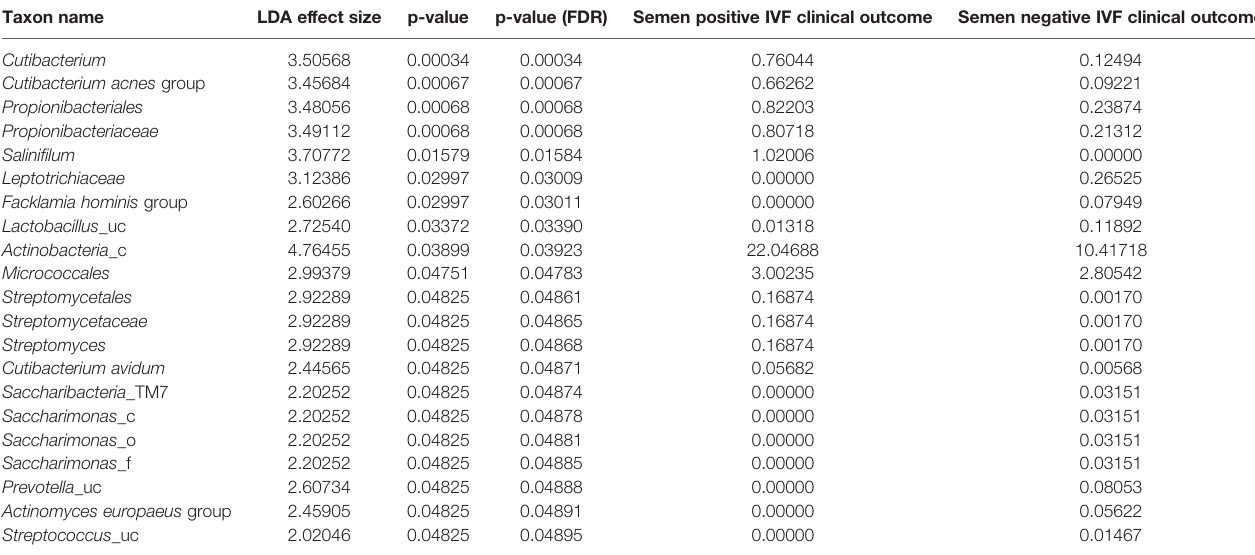
TABLE 2 | LefSe comparison of the taxonomic biomarkers in the seminal fl uid of men that had positive IVF clinical outcome and seminal fl uid of those with negative IVF clinical